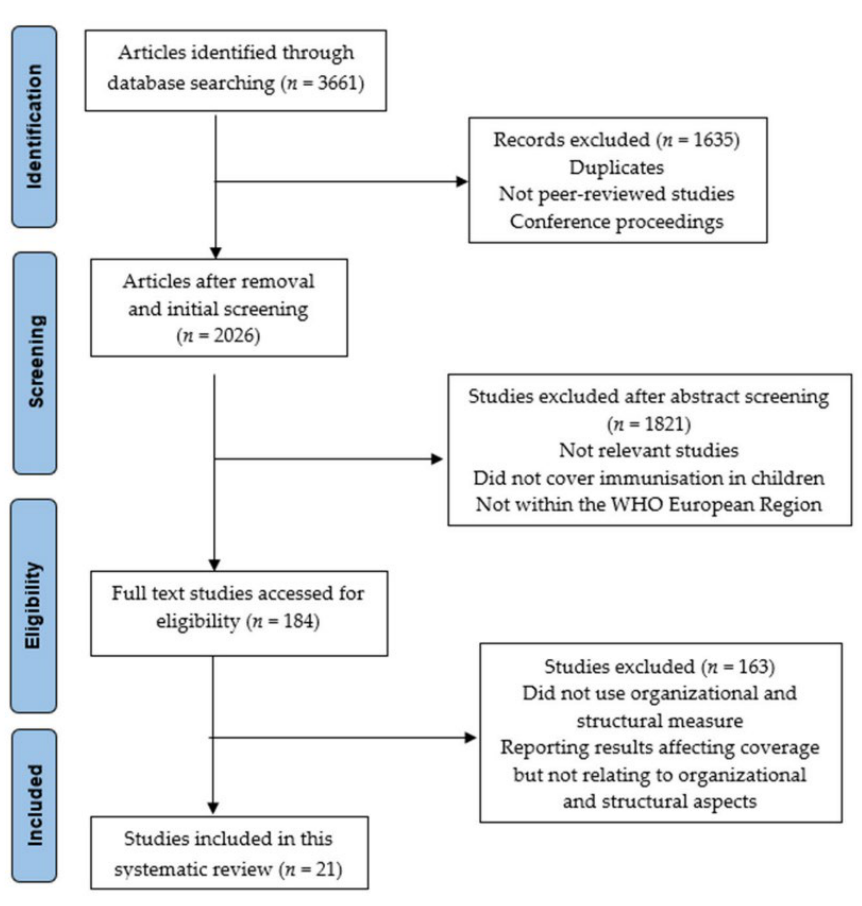
Figure 1. PRISMA flow diagram illustrating the search strategy and study process of selecting.